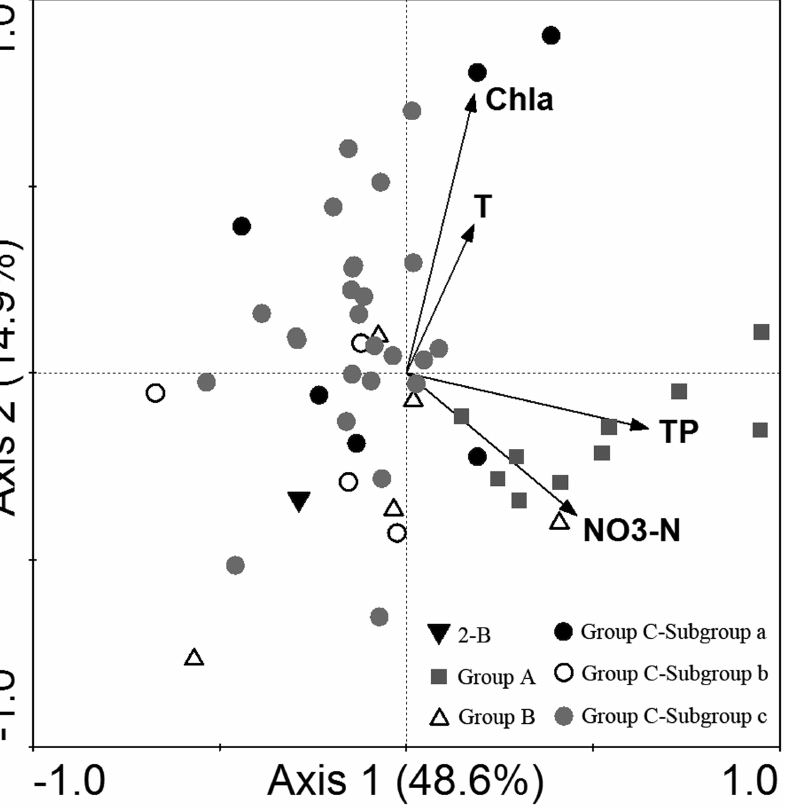
Figure 10. Redundancy analysis (RDA) ordination plot. The ordination plot shows the relationship between ciliate communities and significant environmental variables. The result was based on square root-transformed biotic and log-transformed abiotic data of 51 effective samples in the northern Beibu Gulf in August 2011. Axis 1 and Axis 2 explained 48.6% and 14.9% of the species-environment relationship respectively. T-water temperature; Chl a - chlorophyll- a ; Sal-salinity; 2-B = bottom sample of station 2. (TIFF).